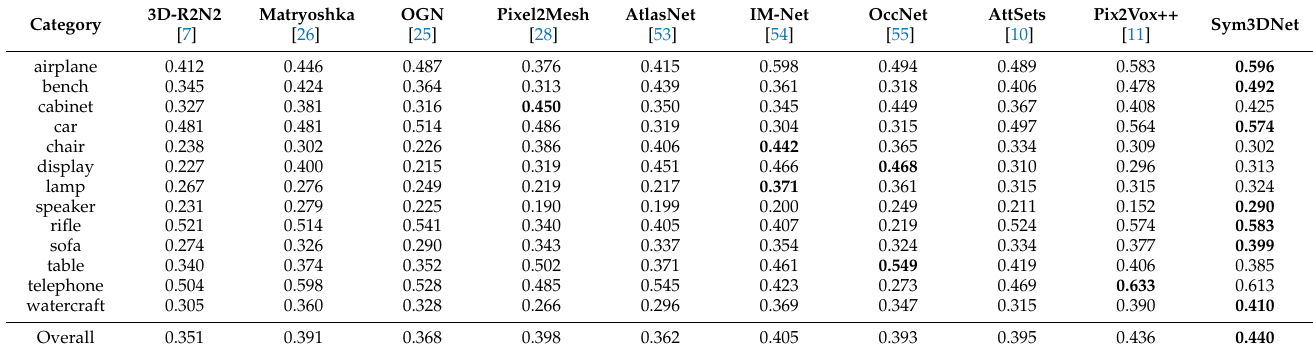
Table 5. The comparison of 3D shape reconstruction from single view on ShapeNet13. We provide F-scores for each category. We use the marching cube algorithm for voxel reconstruction to triangular mesh output. For the best category, we highlight the scores in